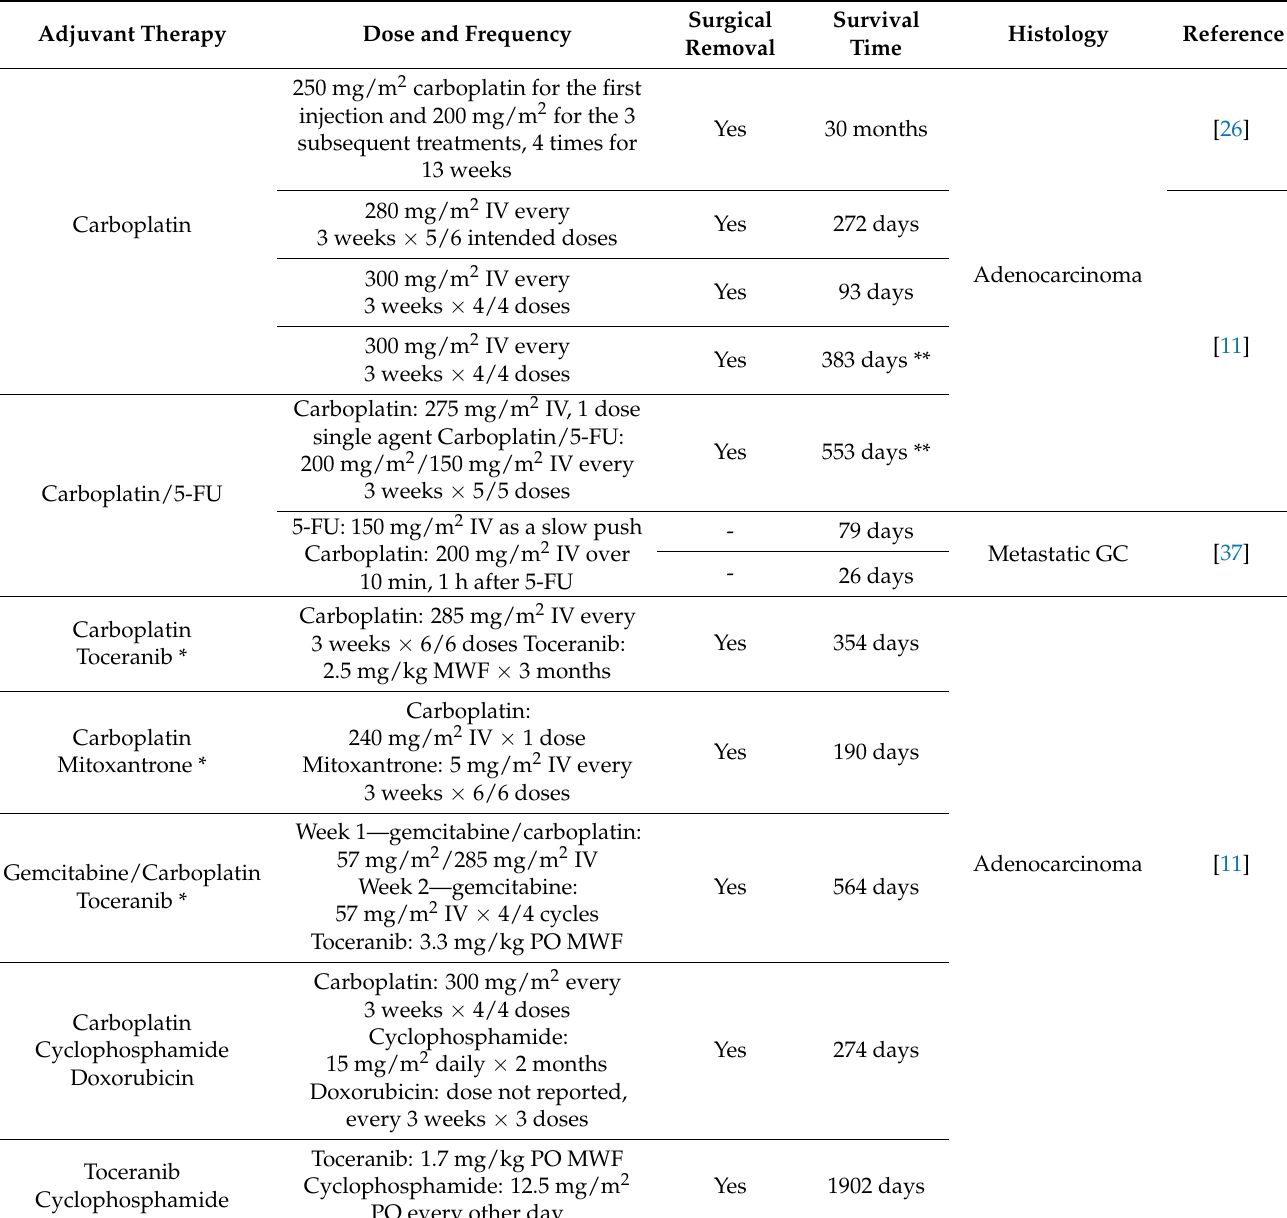
Table 2. Chemotherapy protocols used for canine gastric